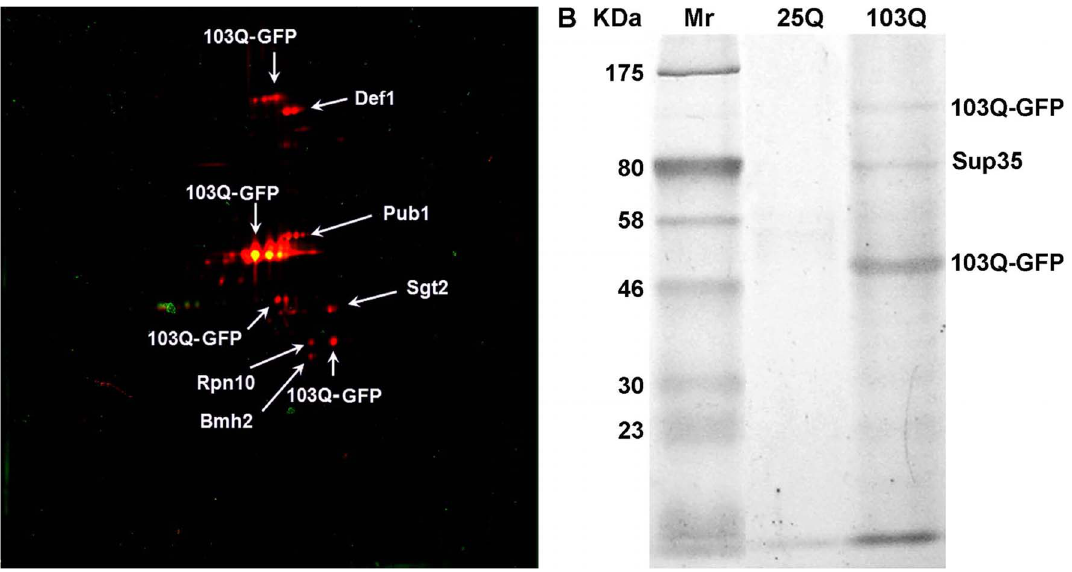
Fig. 5. Identification of proteins forming SDS-insoluble aggregates in cells expressing 103Q-GFP. 2D-DIGE image of proteins of aggregates isolated using SDS (A). Spots corresponding to proteins from cells expressing 103Q-GFP and 25Q-GFP (control) are red and green, respectively. SDS-PAGE image of proteins from the same DRAFs that were insoluble in UTC buffer (B). Mr – protein molecular mass markers. Proteins identified by mass-spectrometry are indicated. Identification data are presented in Table 5 and S5 Table.